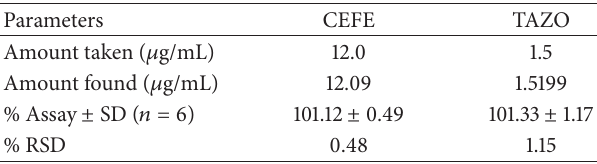
Table 1: Analysis of marketed formulation. Table 2: Results of validation